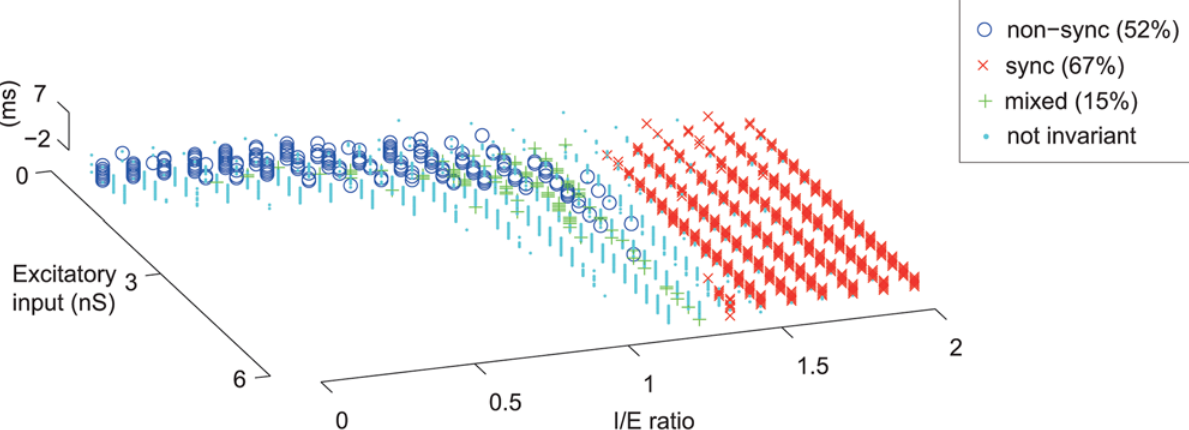
Fig 10. Invariance of response type across varying spontaneous rates. Response type invariance across varying spontaneous rates (between 0 – 40 spk/s). Model parameters yielding one response type across all spontaneous rates tested are indicated [non-sync (o), sync (x), mixed (+)]. Model parameters where neurons changed between response types (e.g. sync ! non-sync) are shown in